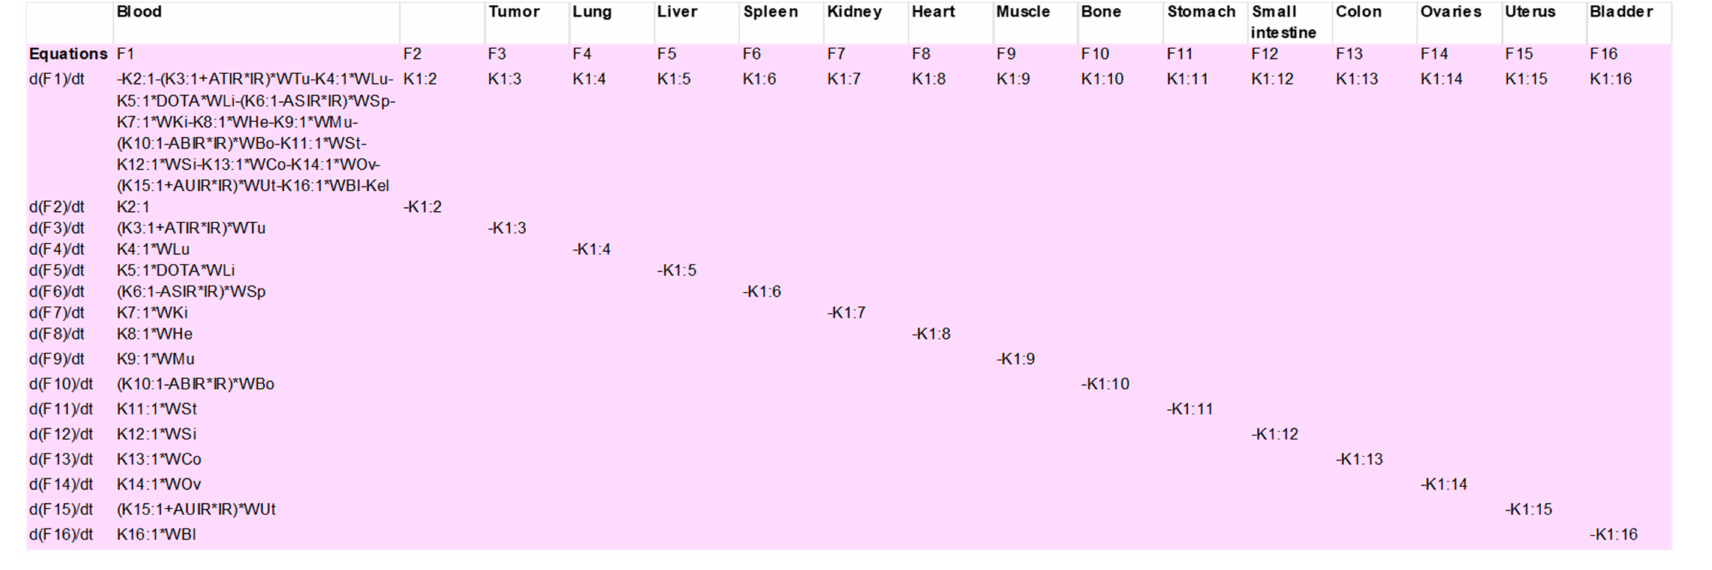
Figure A3. Example of formulas used for modeling each measured